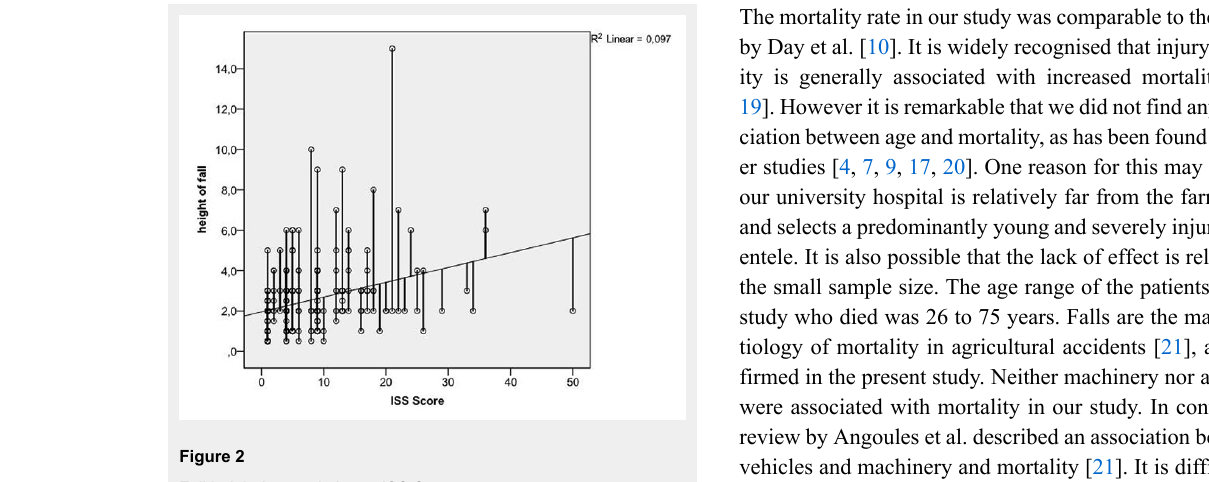
Fall height in correlation to ISS